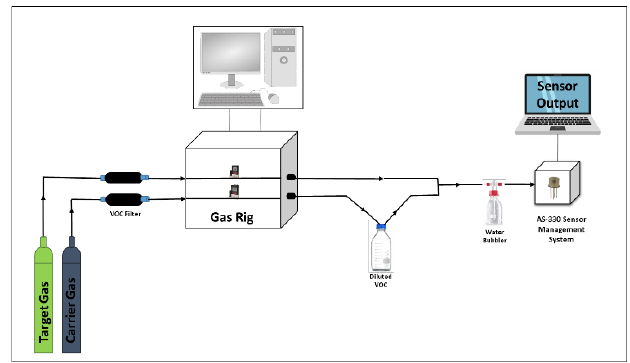
Figure 2. Gas-rig setup.